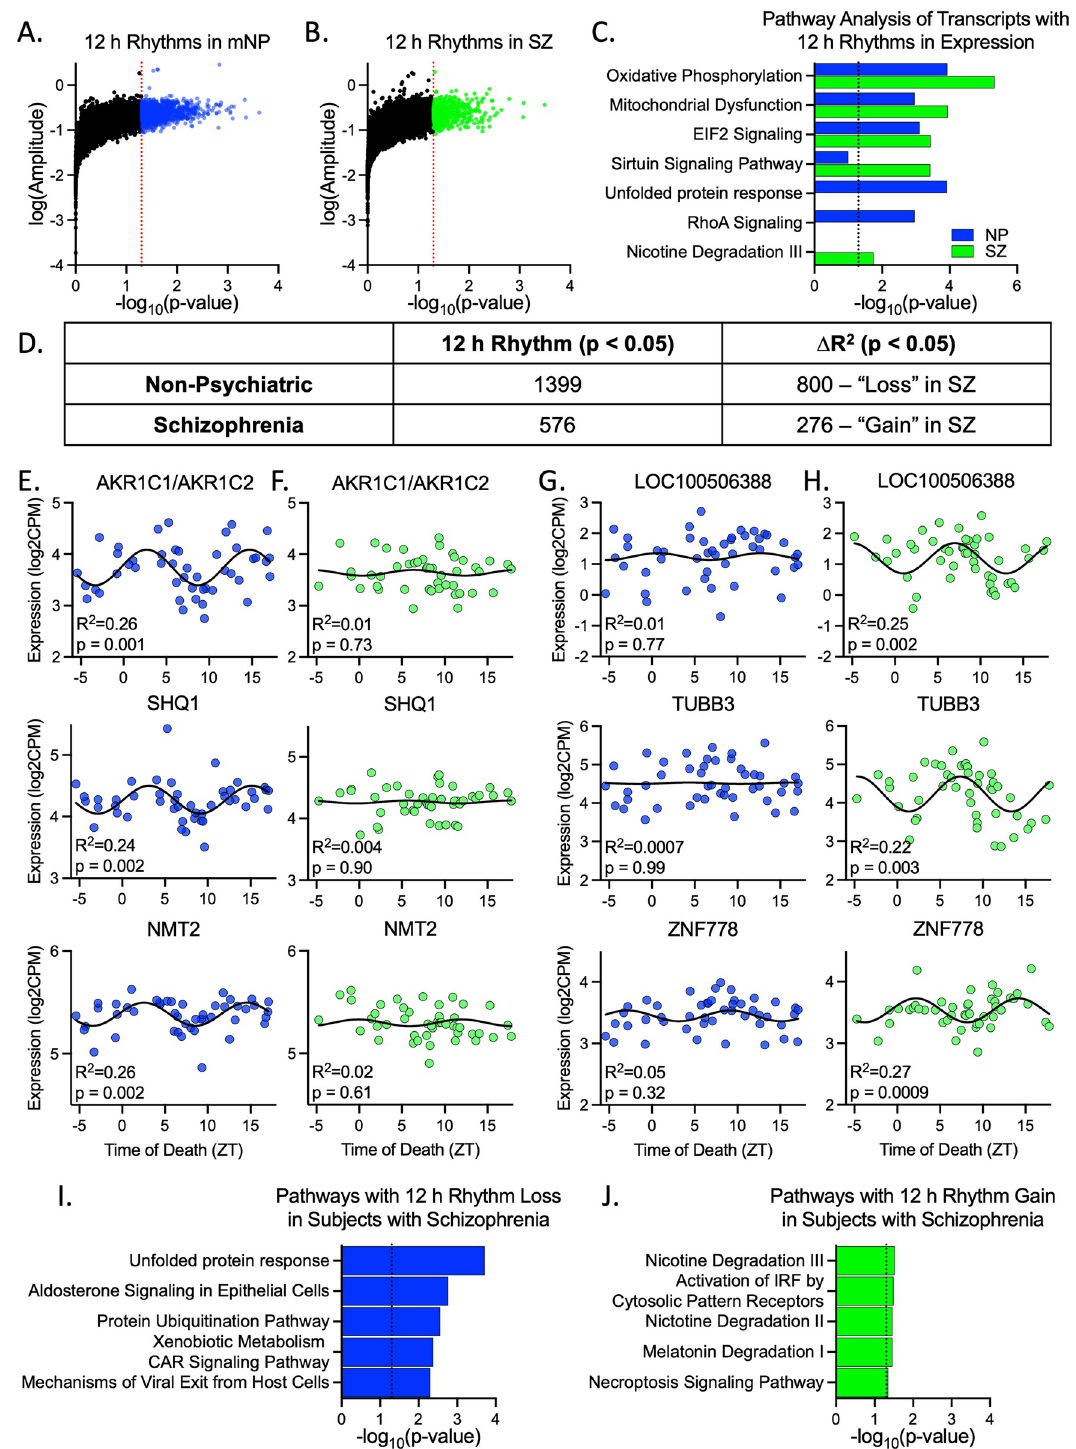
Fig 3. 12 h rhythm reprogramming in SZ. NLR analysis identified 12 h rhythms in the ( A ) mNP and ( B ) SZ cohorts. ( C ) IPA of transcripts with significant 12 h rhythms. ( D ) Number of transcripts identified as having a significant 12 h rhythm or a significant difference in goodness of fit (R 2 ) between the two cohorts (deltaR 2 ). ( E - H ) Examples of genes that ( E - F ) lose or ( G - H )gain 12 h rhythms in SZ. Expression values for these graphs can be found in S6 File. Gene expression over time is shown for both the ( E , G ) mNP and ( F , H ) SZ cohorts. ( I - J ) IPA of transcripts that significantly ( I ) lose or ( J ) gain rhythmicity in SZ. Results of the NLR